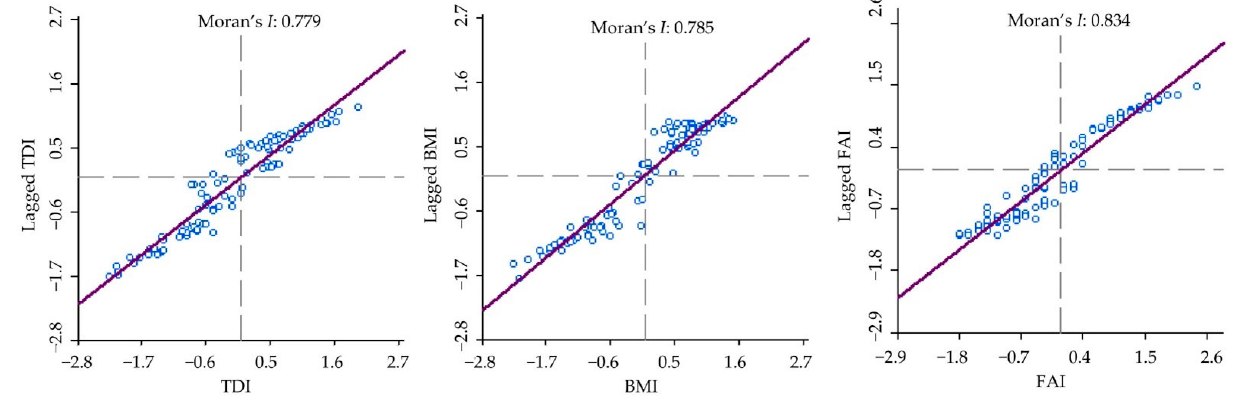
Figure 4. Moran’s I values of the three biological indicators.